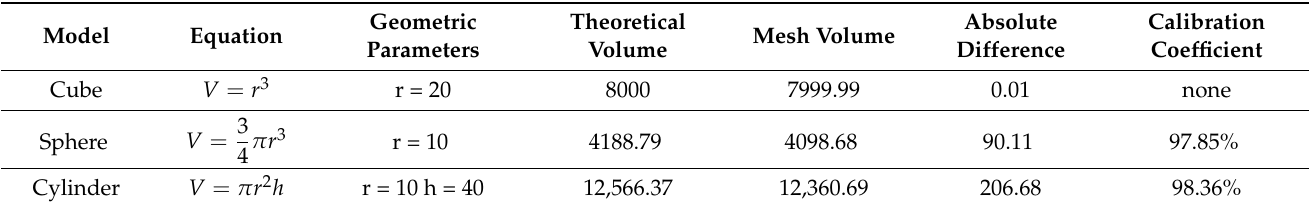
Table 1. The calculation of true values (the mesh volume) for regular shape objects.